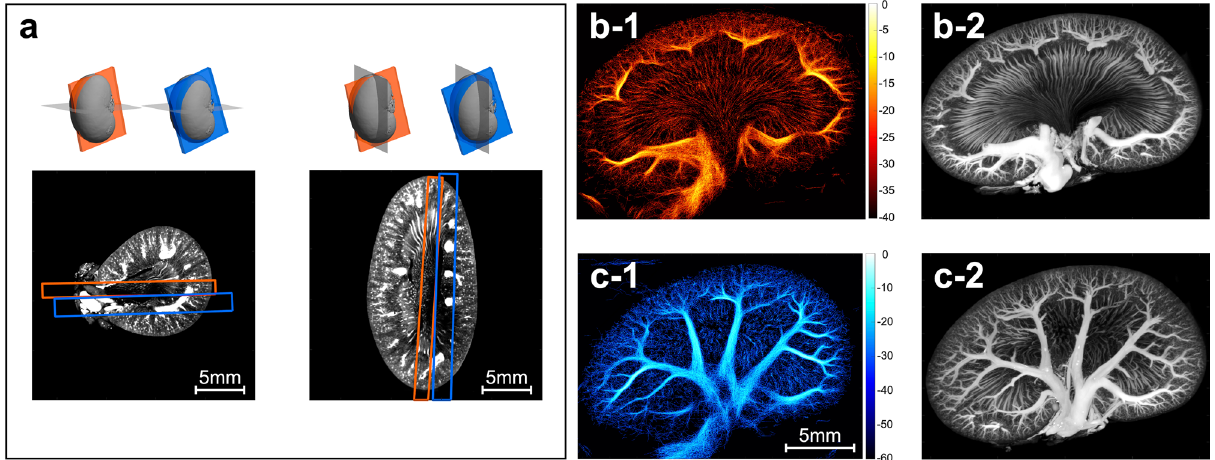
Figure 1. Co-registration of μ CT and super-resolution ultrasound images. ( a ) Co-registration of the two 2D super-resolution ultrasound images to the μ CT volume. The images show the two ultrasound fields of view in the μ CT coordinate system in an axial μ CT slice to the left and a sagittal μ CT slice to the right. ( b-1 , c-1 ) show the two super-resolution ultrasound images (intensity maps). The images are log-scaled with a dynamic range of 40 and 60 dB, respectively. The color bar shows the value of intensity after logarithmic compression. Intensity corresponds to the number of detected microbubbles. ( b-2 , c-2 ) show the μ CT maximum intensity projections in the super-resolution ultrasound image